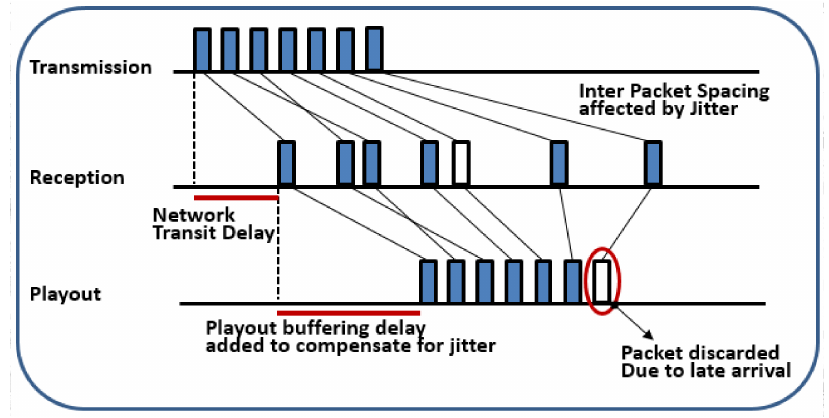
Figure 2. Network jitter affects reception time and is corrected in the playout